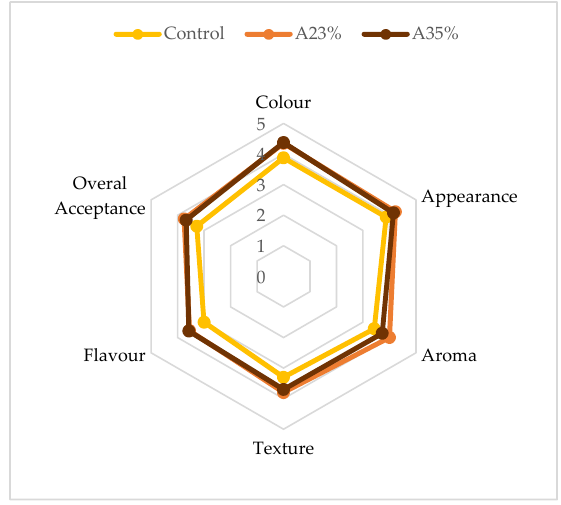
Figure 2. Sensorial analysis of GFB: control, 23% and 35% acorn flour incorporation. Panelists showed a preference for bread with 23% and 35% acorn flour, in comparison with the control bread. The overall acceptance was 3.80, 3.70, and 3.2 respectively.